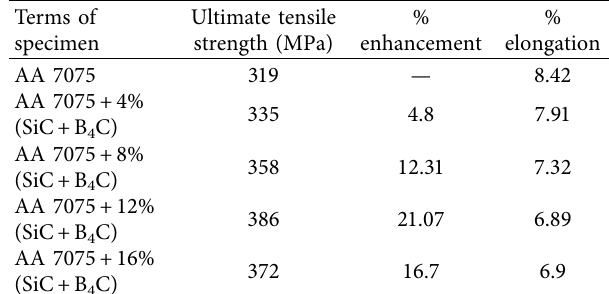
Table 6: Results of tensile strength along with %